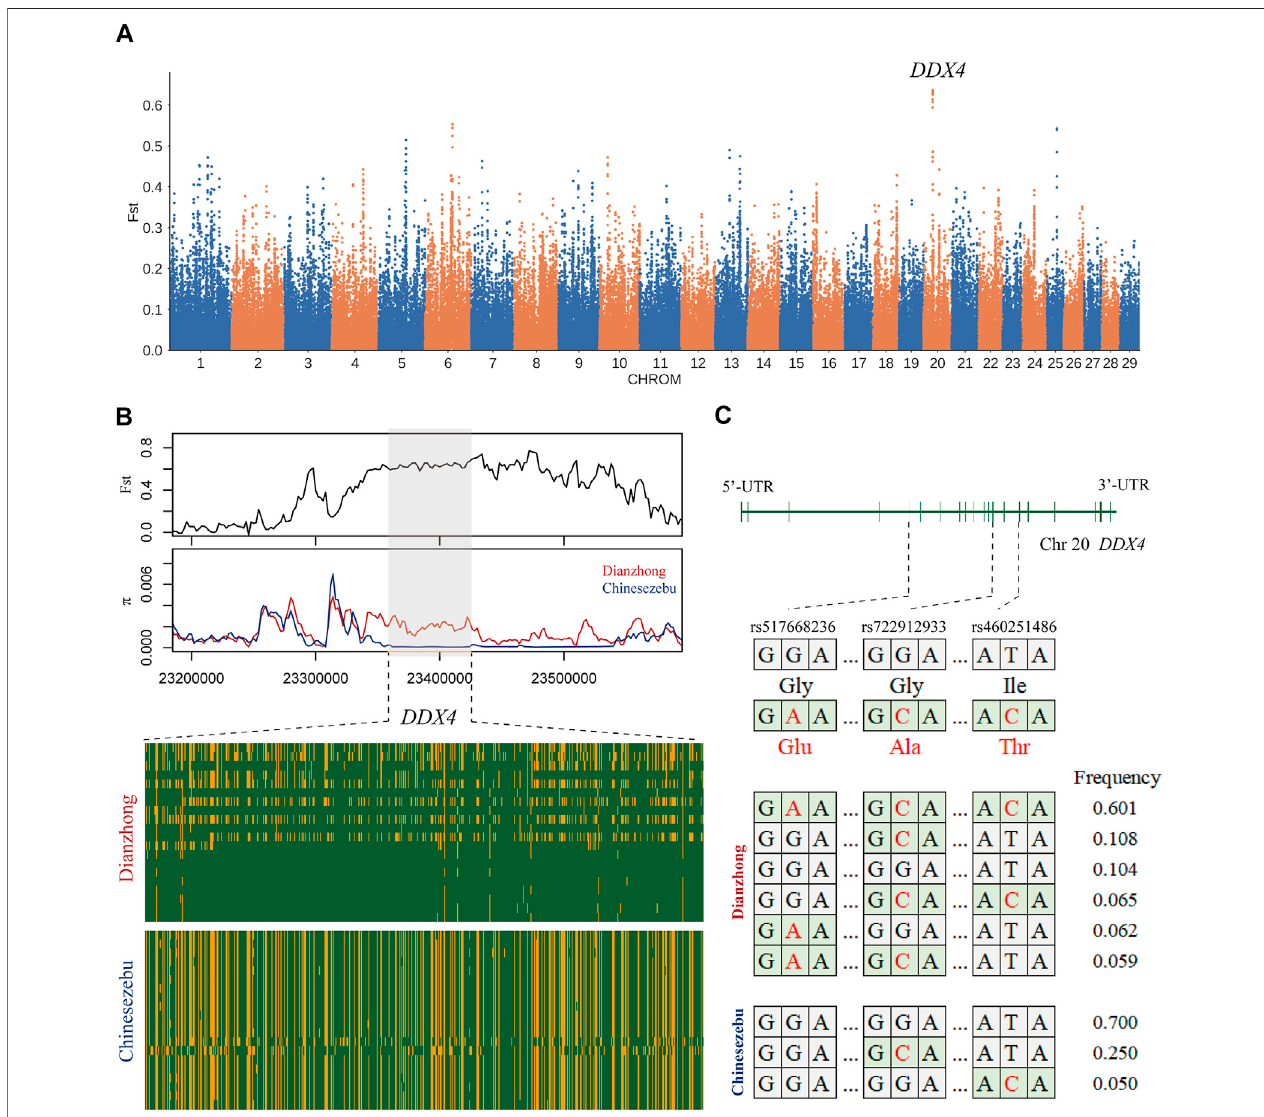
FIGURE2| AnalysisofthesignaturesofpositiveselectionbetweenDianzhongcattleandChinesezebu. (A) Manhattanplotofselectivesweeps. (B) Fstand π plots and haplotype patterns heatmap of the DDX4 gene region. (C) Structure of DDX4 with exons indicated by vertical bars. Three missense mutations and their haplotypes were highlighted in